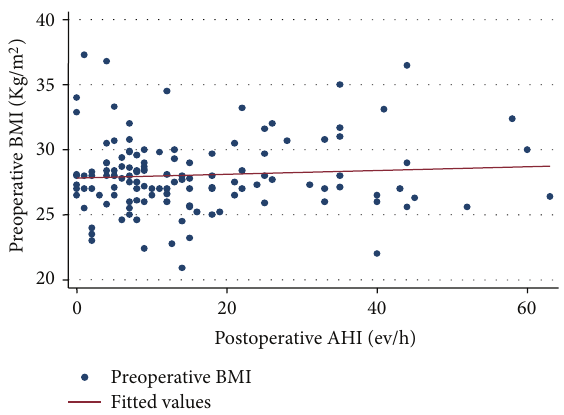
Figure 4: Statistical correlation between preoperative BMI and postoperative